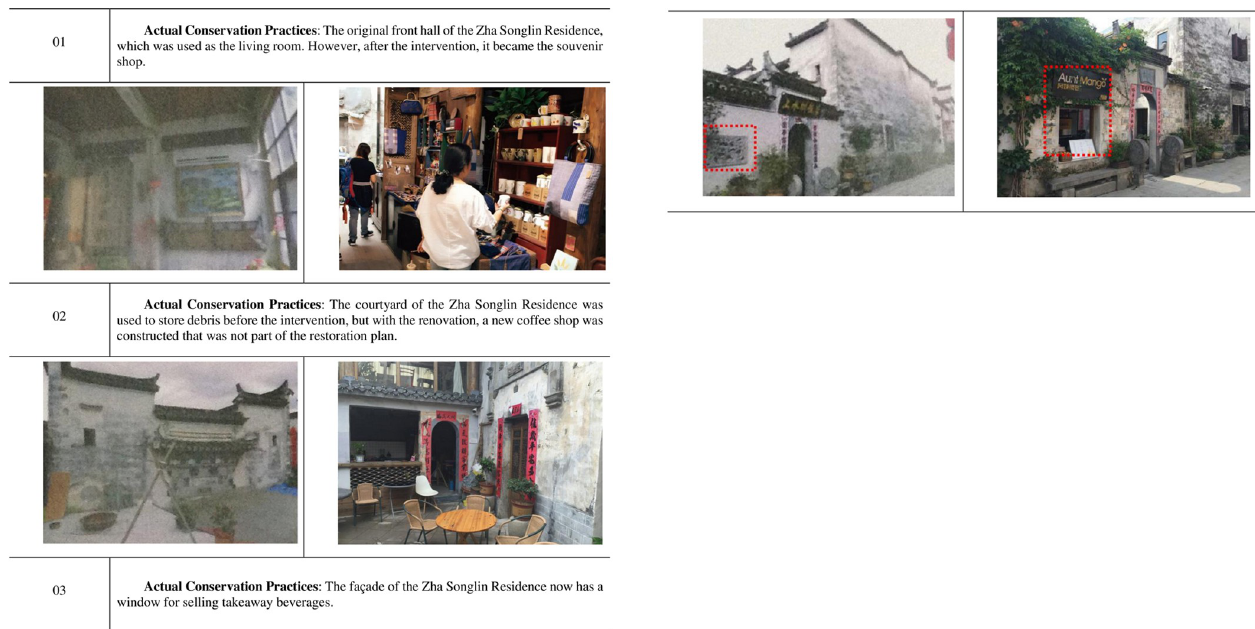
Fig 7. Examples of the conservation practices applied to the Zha Songlin